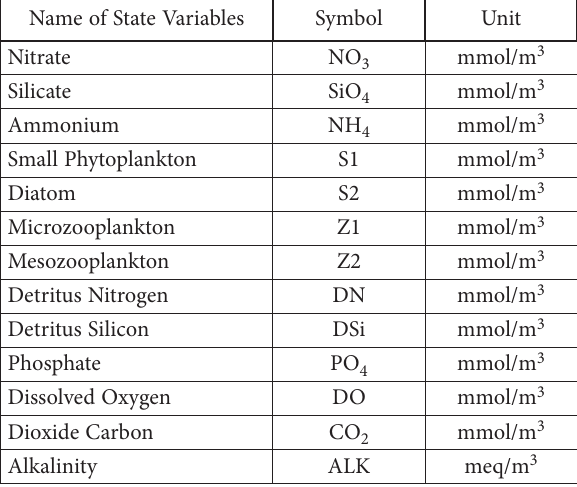
Table 1. List of CoSiNE model variables